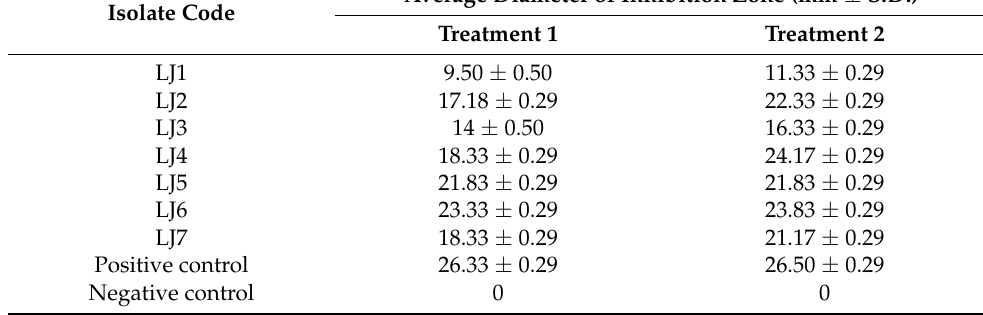
Table 1. Results of antibacterial activity analysis of A. dorsata gut-associated bacterial isolates against N. gonorrhoeae